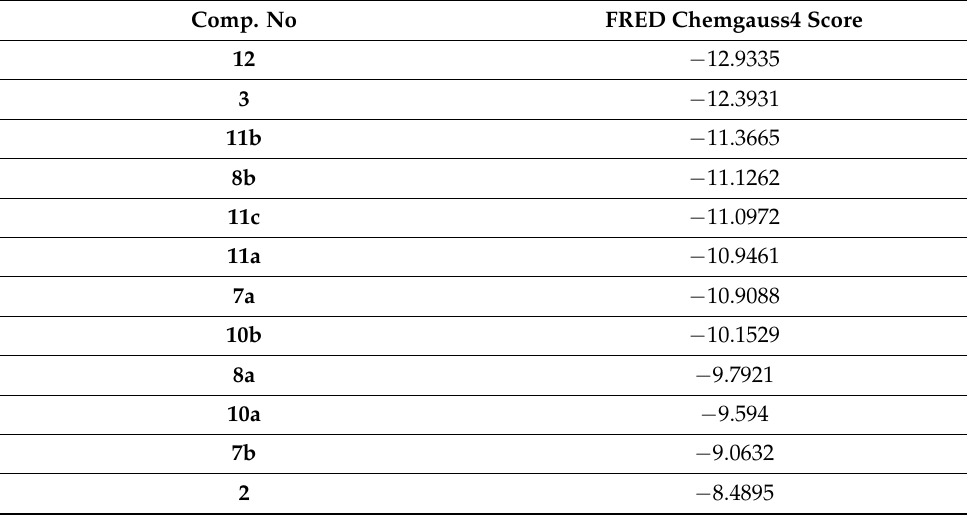
Table 3. FRED Chemgauss4 scores for the docked